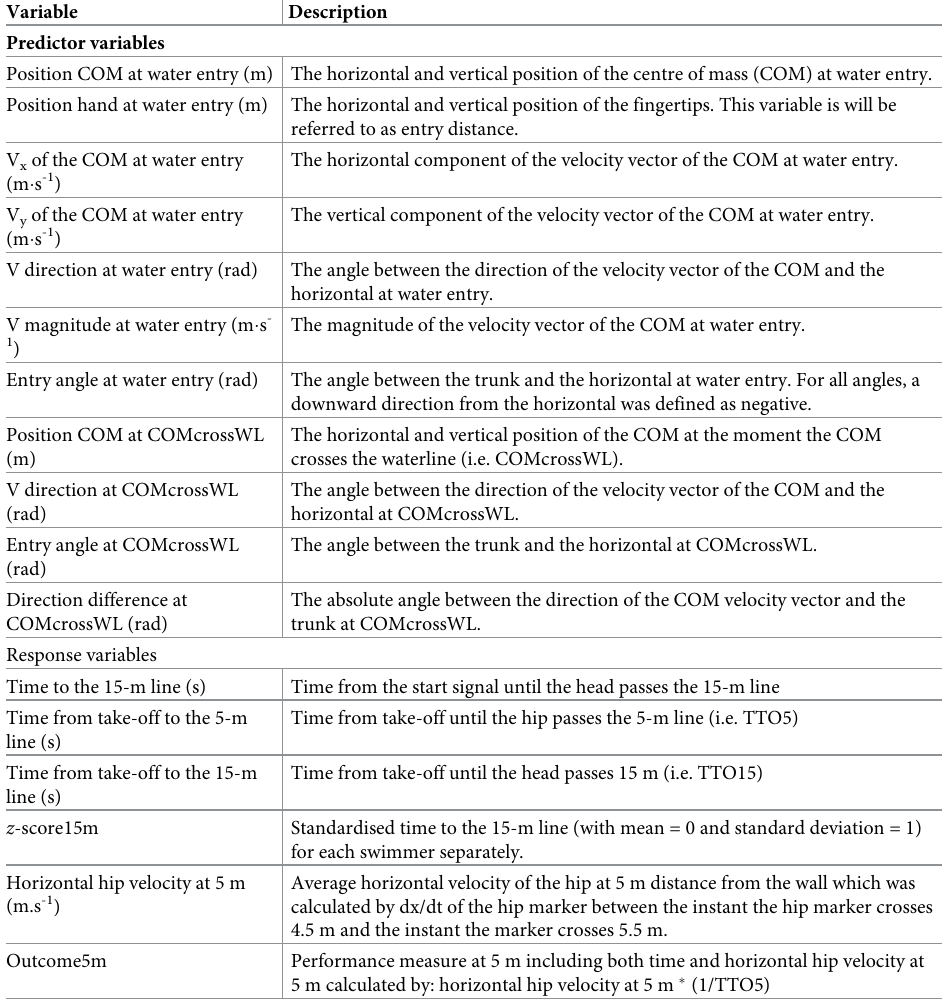
Table 3. Definitions of the predictor (independent) and performance (dependent)